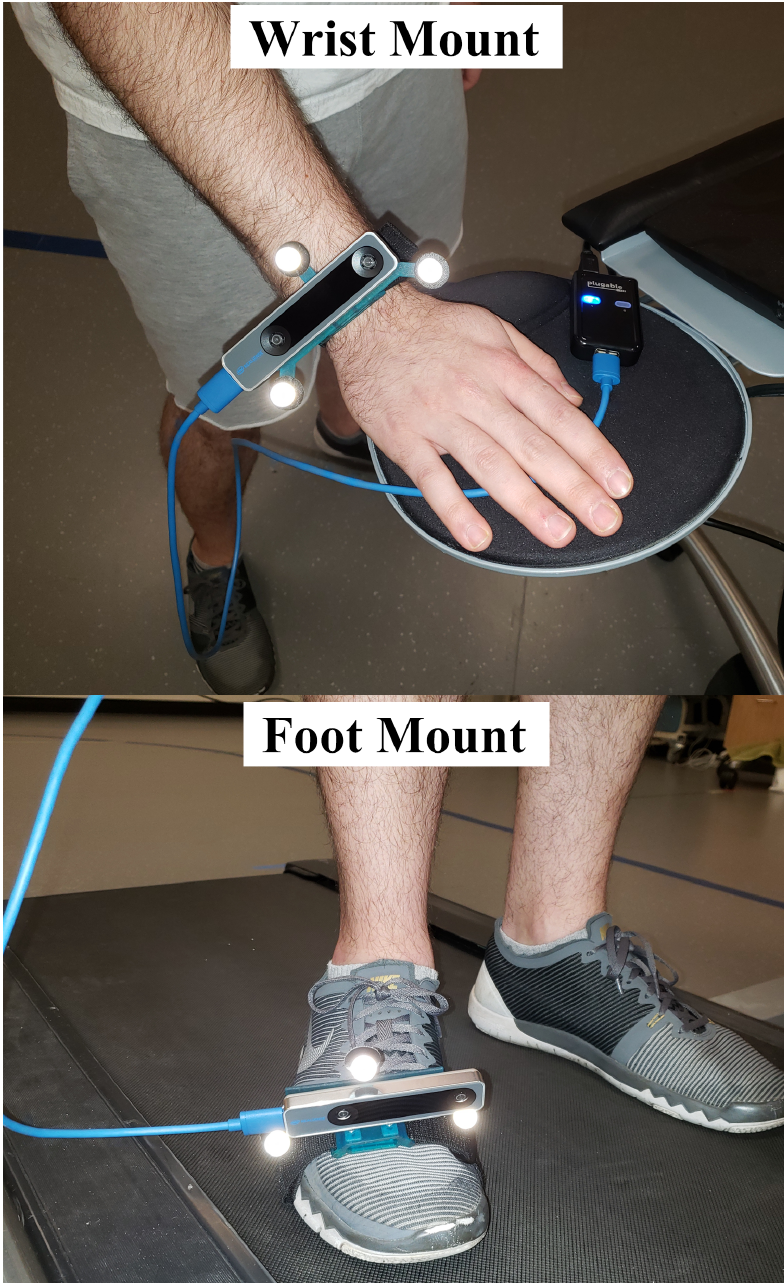
Figure 2. Attached jig fitted with Intel T265 camera and reflective